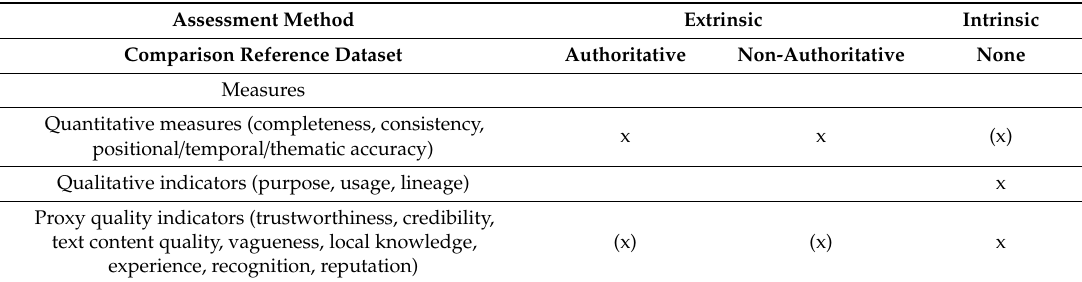
Table 1. Di ff erent methods and measures for VGI quality